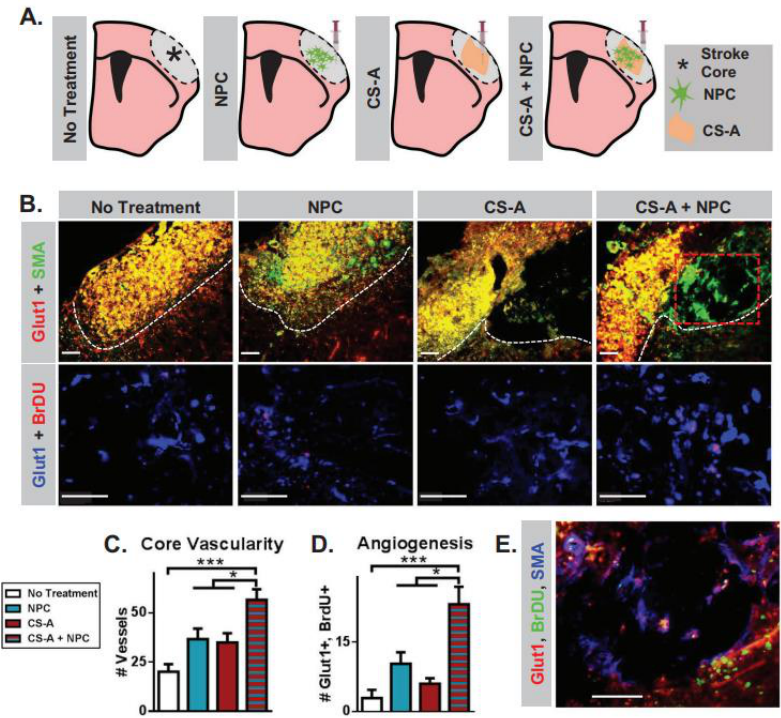
Figure 4. ( A ) Schematic illustration of treatment groups following strokes in mice. ( B ) Vessels in the necrotic stroke core across treatments. ( C ) Newly formed endothelial cells across treatments. ( D ) Analysis of the vascularity angiogenesis. ( E ) Muscular artery formation images. *, *** indicate p < 0.05, p < 0.0005, respectively (1-way ANOVA, Tukey’s post-hoc). Reproduced with permission from [65]. Copyright 2020,